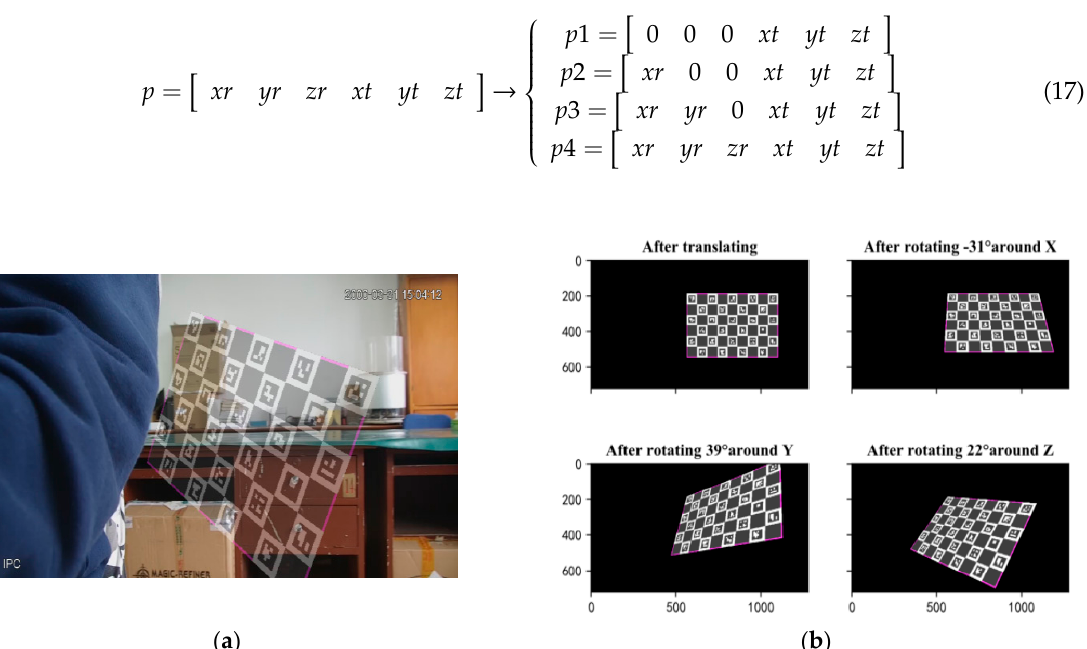
Figure 5. ( a ) Example of pose projection. ( b ) Example of pose decomposition projection. First, translate to the right of the image, and then rotate 30 degrees around the negative half axis of X -axis, and then rotate 39 degrees around the positive half axis of Y-axis, finally, rotate 22 degrees around the positive half axis of Z-axis.